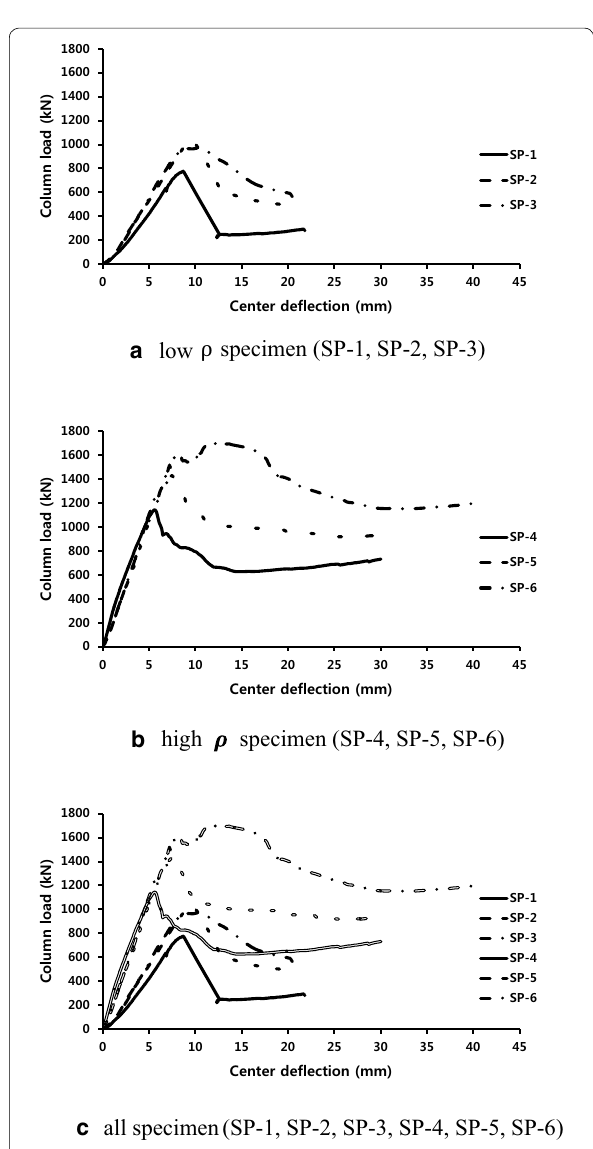
Fig. 4 Vertical load–center deflection relationships of test specimens.